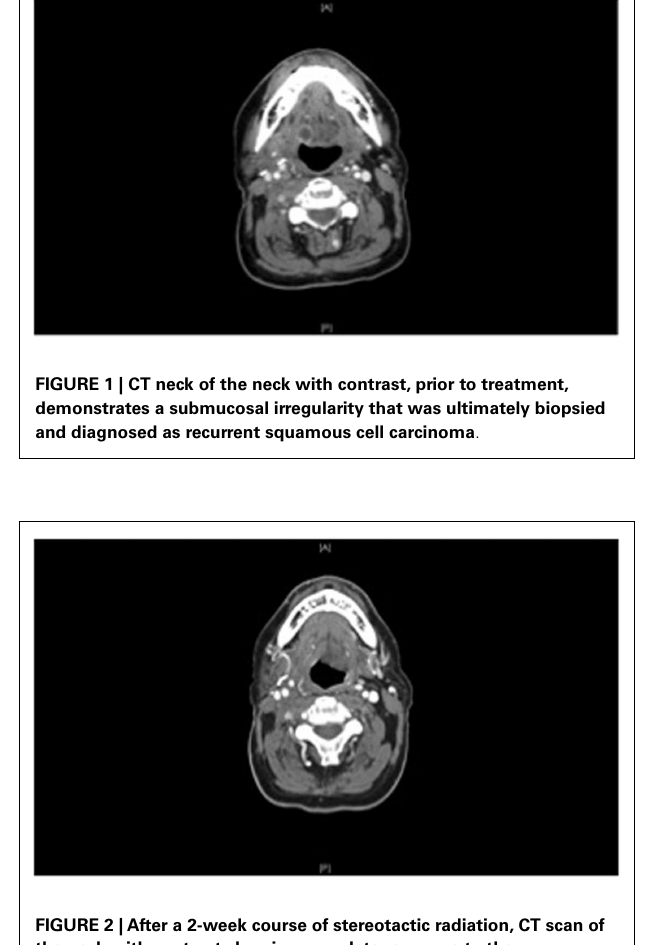
FIGURE 2 |After a 2-week course of stereotactic radiation, CT scan of the neck with contrast showing complete response to therapy .